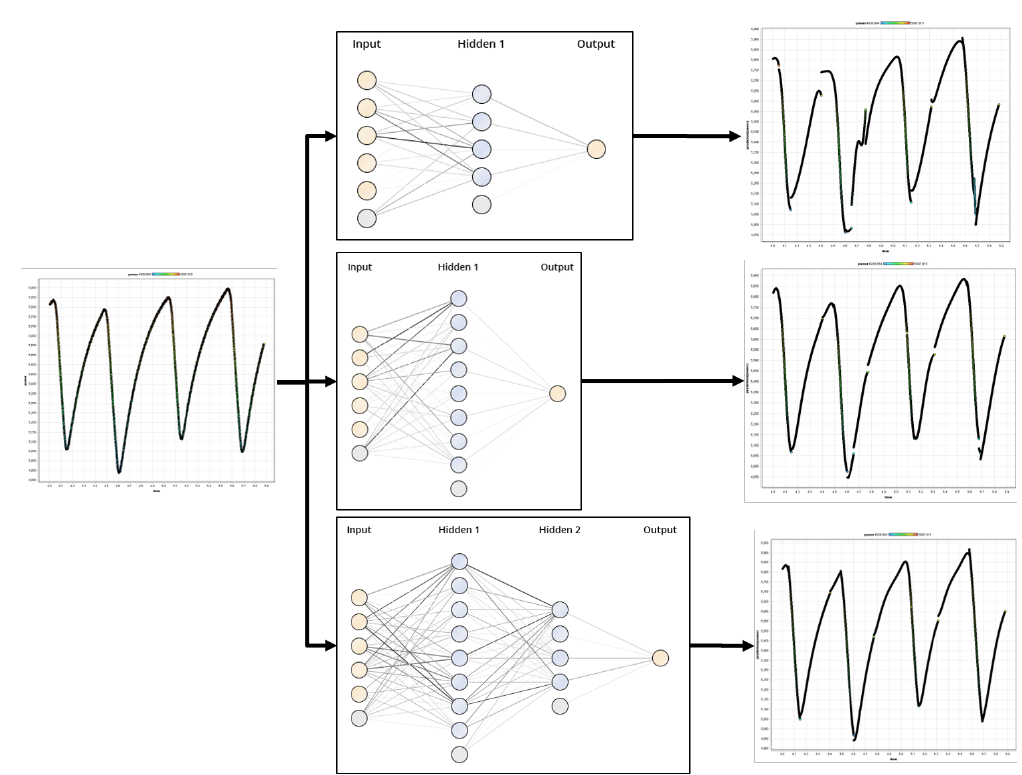
Figure 10. Variations of the neural network